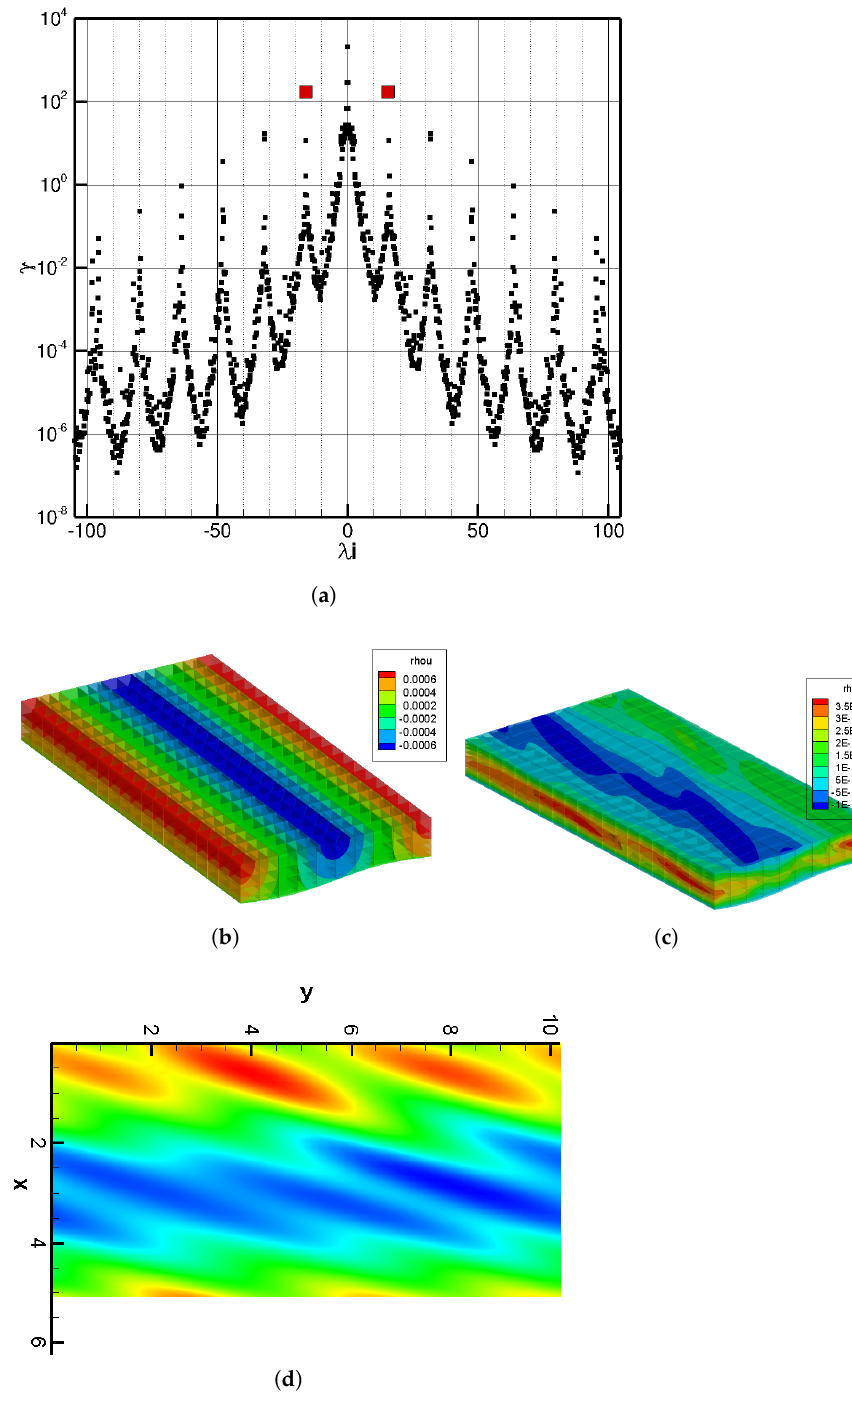
Figure 7. DMD analysis of the laminar Re = 1150 wavy wall channel flow. Relevance of the different modes, measured by Equation (11), in ( a ). Streamwise ( b ) and spanwise ( c ) fields of the dominant mode (in red in a ); ( d ) shows ( c ) cut at z = −